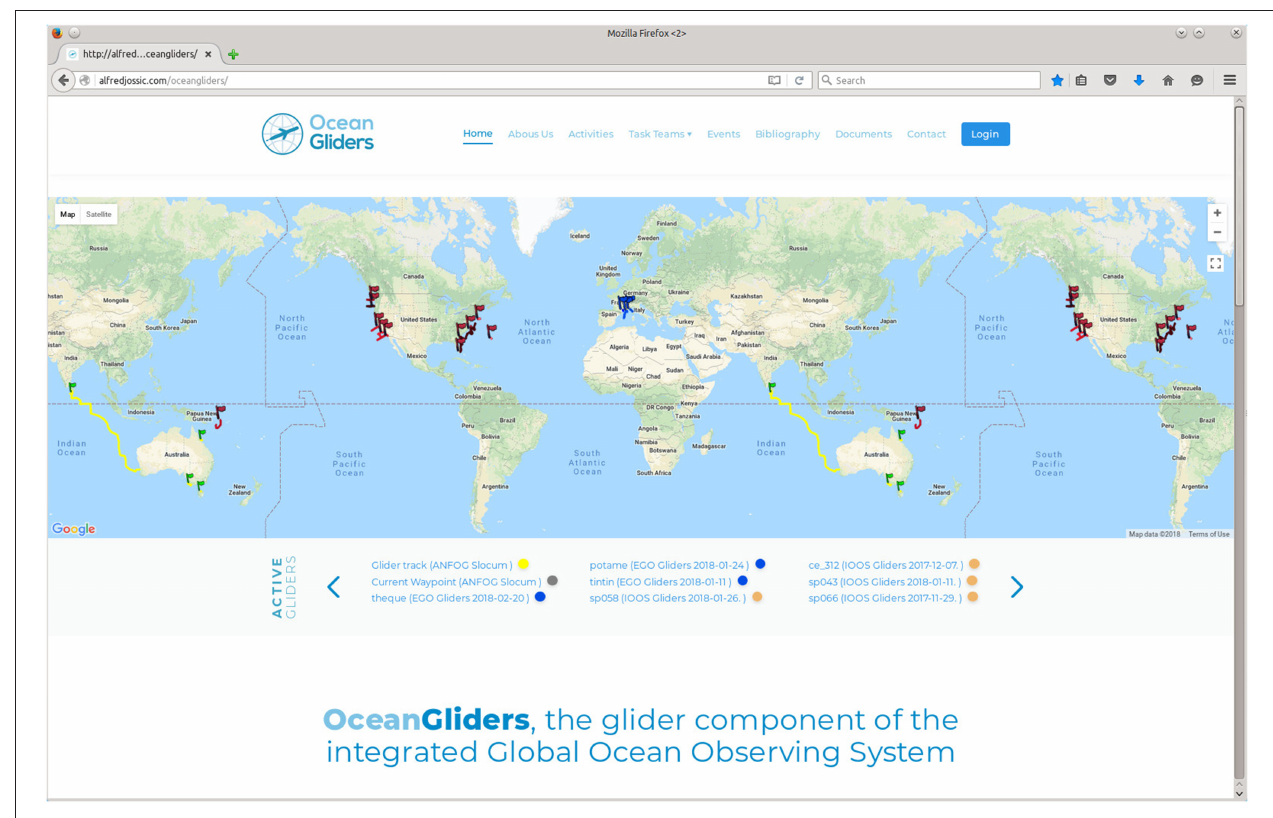
FIGURE 3 | The global active glider fleet trajectory map, updated daily (from http://anfog.ecm.uwa.edu.au/index.php?page=global_gliders, accessed 23 August, 2018).